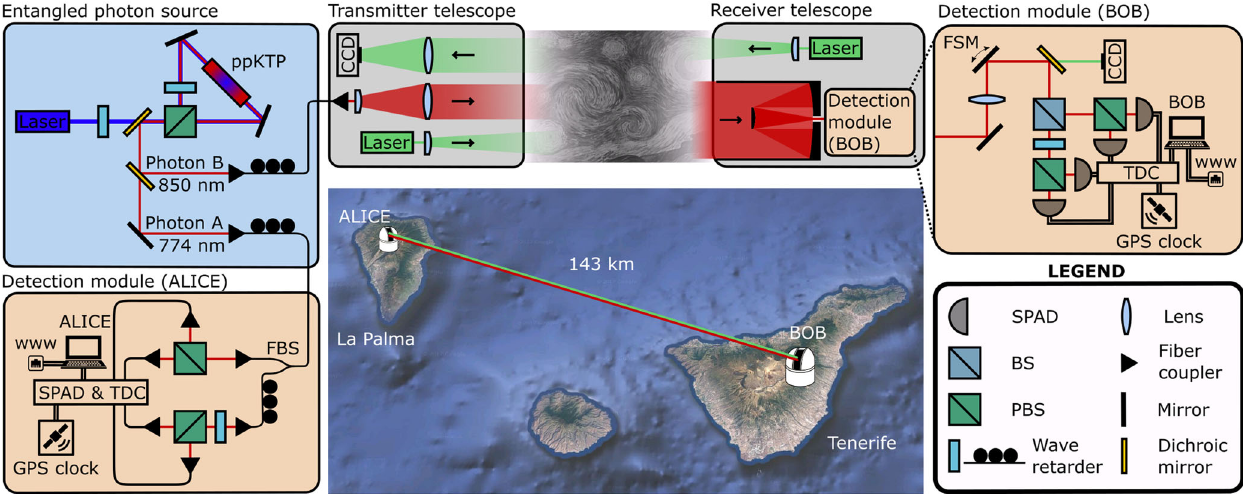
Fig. 2 Sketch of the experimental setup. Alice and Bob were located on the Canary islands of La Palma and Tenerife, respectively, amounting to a free-space link distance of 143 km. Polarization-entangled photon-pairs were produced in SPDC by bidirectionally pumping a ppKTP crystal placed in the center of a Sagnac interferometer. Both Alice ’ s and Bob ’ s measurements were preceded by a random polarization basis choice realized by non-polarizing beamsplitters (BS). The measurement in one of two mutually unbiased polarization bases was achieved by polarizing beamsplitters (PBS), followed by detection with single-photon avalanche diodes (SPAD). All detection events were recorded with time-to-digital converters (TDC) disciplined by pulse-per-second signals from GPS clocks. Storage and post-processing of the timestamps was done with PCs, which were both connected to the Internet, constituting the classical communication channel. For the purpose of pointing, acquisition, and tracking, the quantum channel was bidirectionally overlapped with two green 532-nm beacon lasers. Map data © 2017 Google.